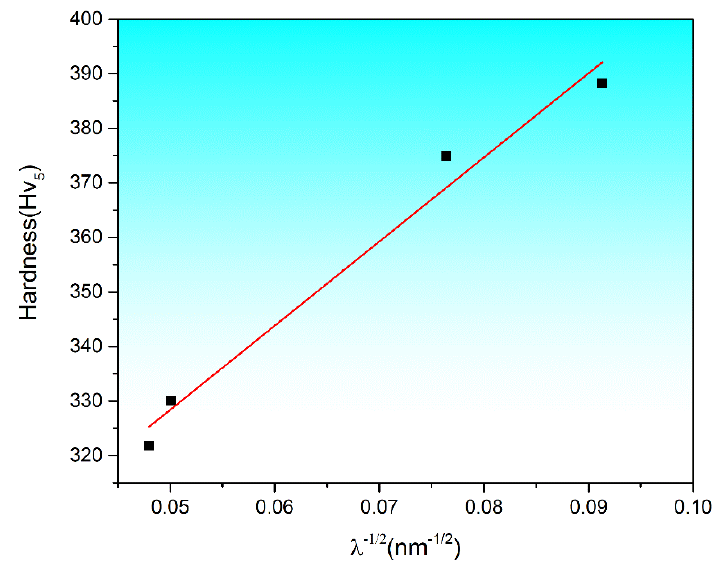
Figure 6. The relationship between lamellar spacing and Vickers hardness.